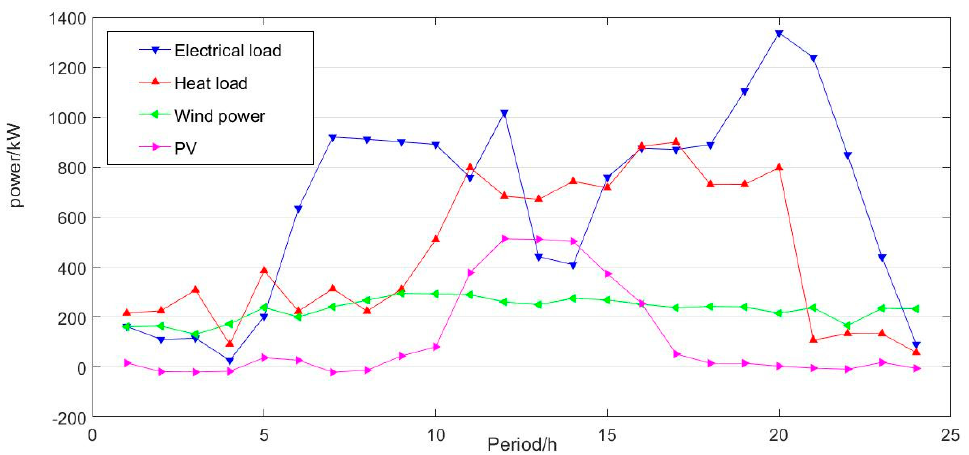
Figure 4. Wind power output, photovoltaic power output, power load, and heat load curves within a typical day in summer (Photovoltaic: PV).